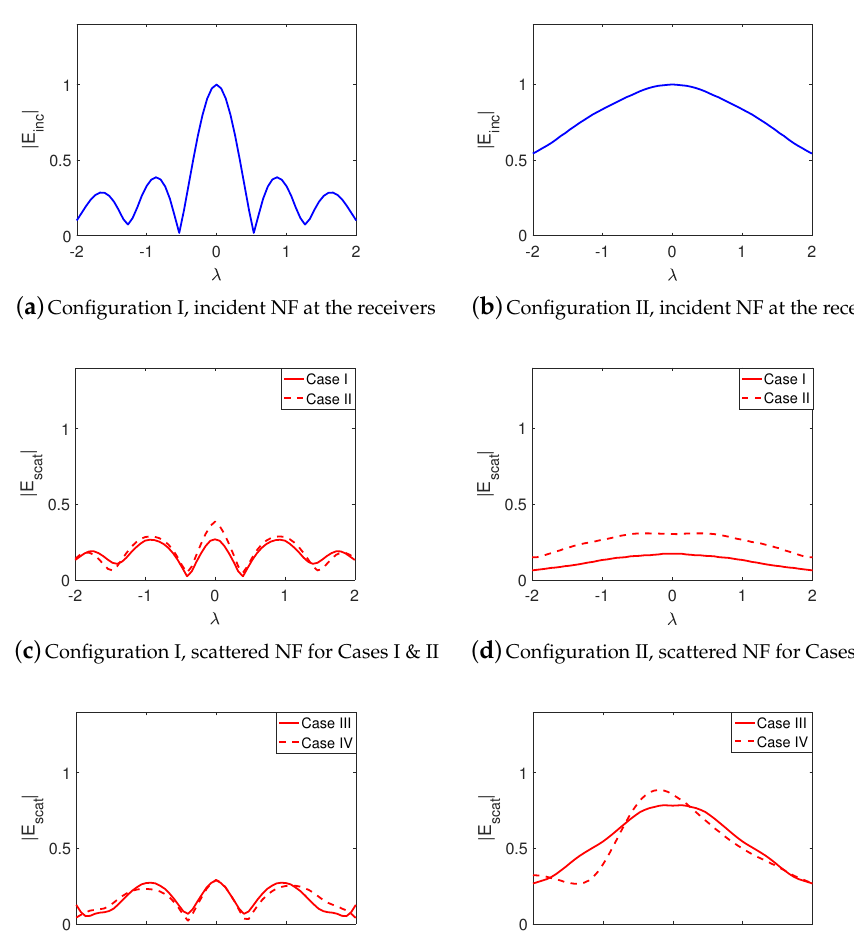
Figure 13. Normalized magnitude of the incident NF distribution for ( a ) Configuration I (Bessel beam) and ( b ) Configuration II (dipole).